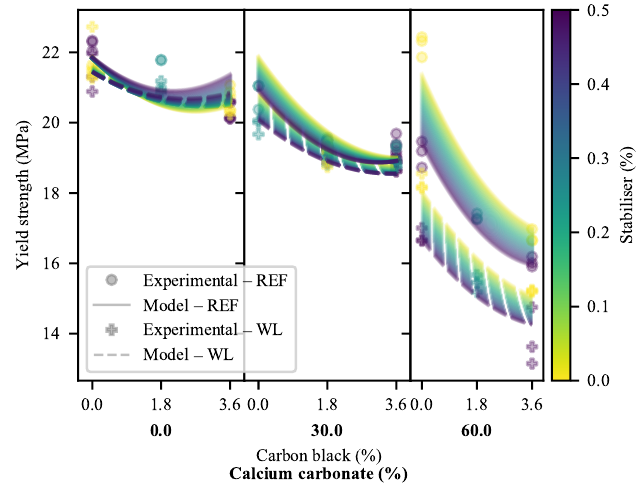
Figure 6. Influence of the specimen type and loadings of calcium carbonate, carbon black and the stabiliser package on the yield strength of the system. Specific attention must be paid to the similarity of the curves, with the distinct exception for those at the 60-CC level. Furthermore, note the exceptional performance of the 0-CB/60-CC/0-SP